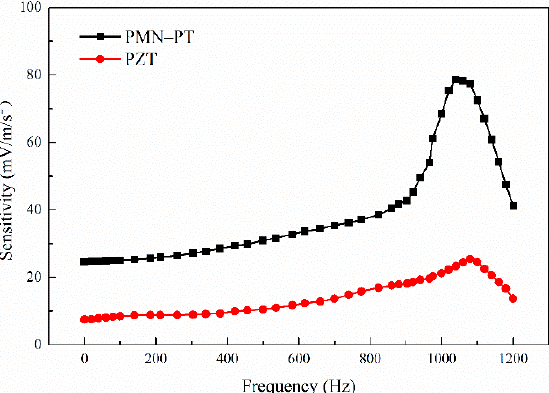
Figure 14. The experimental sensitivity of the simply supported beam transducer is based on PMN-PT and PZT.